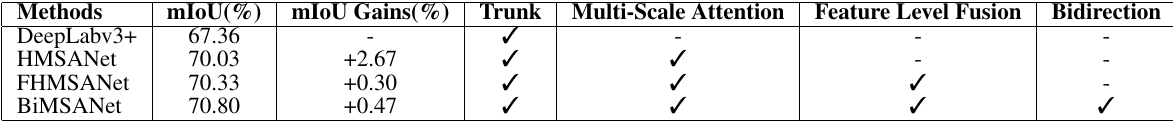
Table 2. Ablation study for models. The performance gains could be observed by gradually adding